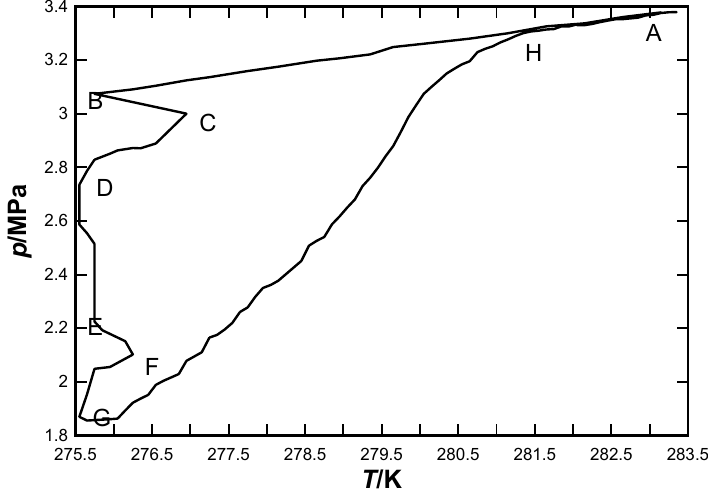
Figure 3. Typical p-T curves for CO non-uniform pore size